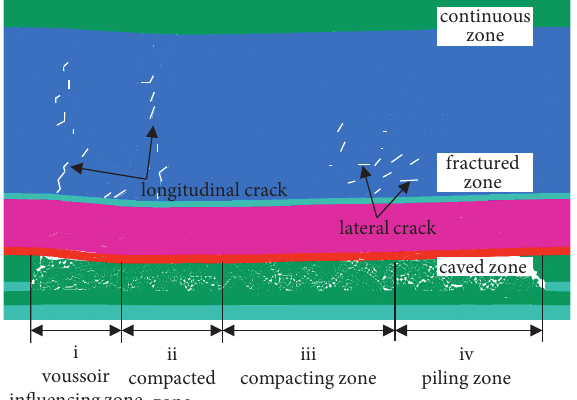
Figure 6: Zones in gob and overlying strata caused by longwall mining.